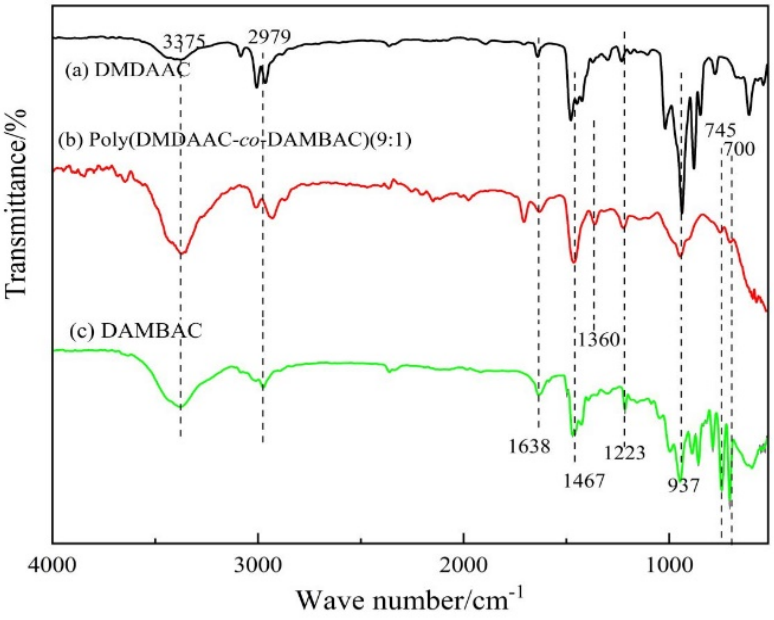
Figure 5. FTIR spectra of DMDAAC ( a ), DAMBAC ( b ), and poly (DMDAAC- co -DAMBAC) (9:1) ( c